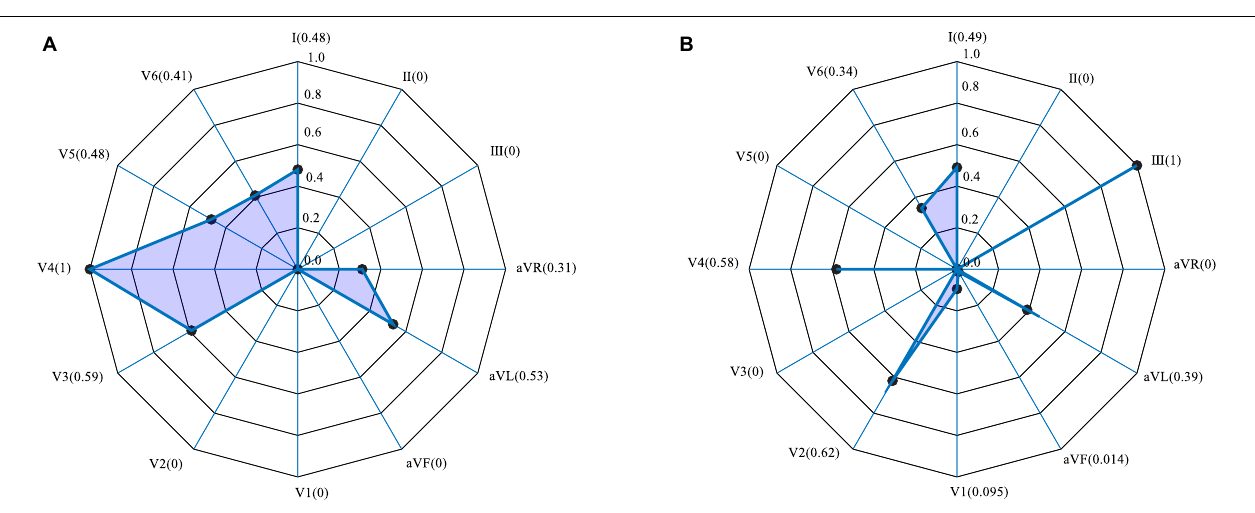
FIGURE 7 | Lead weighting distribution obtained by Grad-CAM for two representative MIs. (A) Anterior; (B)